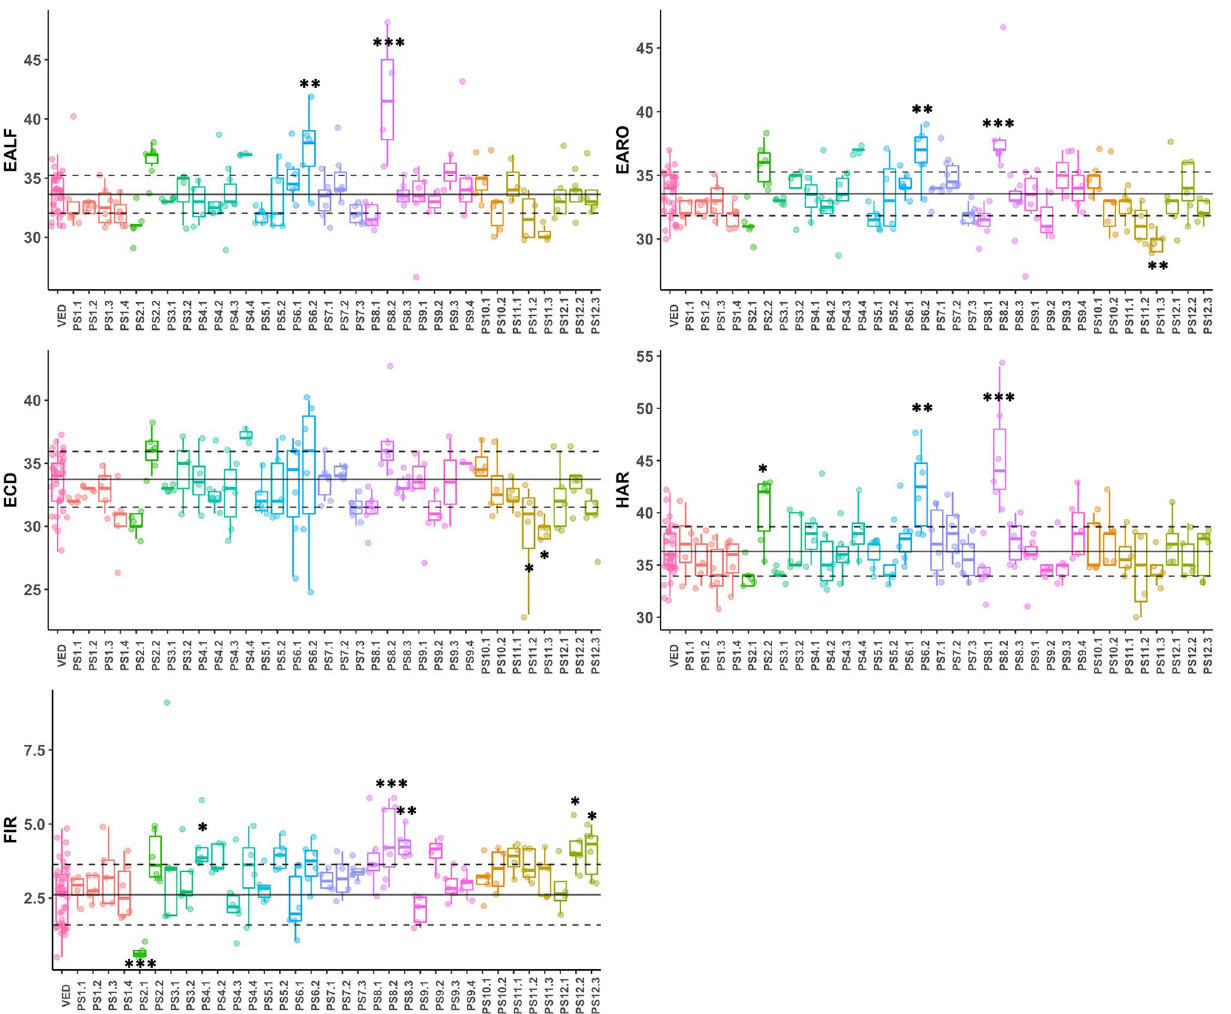
Figure 6. Boxplot representing the values of climacteric ripening traits for ILs. Each dot represents a replicate, the black solid line corresponds to the average and the grey dashed lines to the average ± SD of the recurrent parent Ved. Significant differences are marked with asterisks: *< 0.05, **< 0.01, ***<